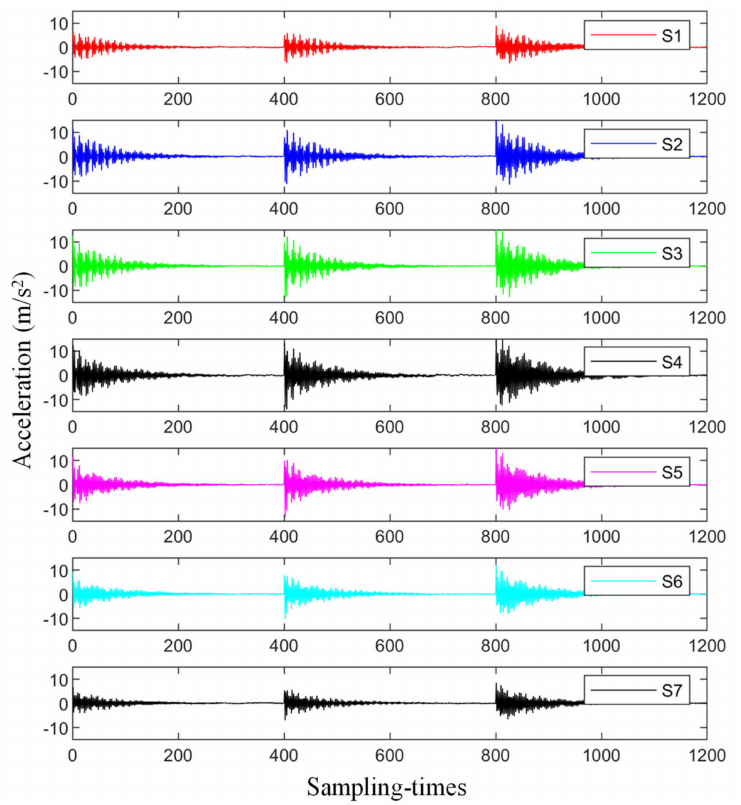
Figure A3. Acceleration signals from the experimental